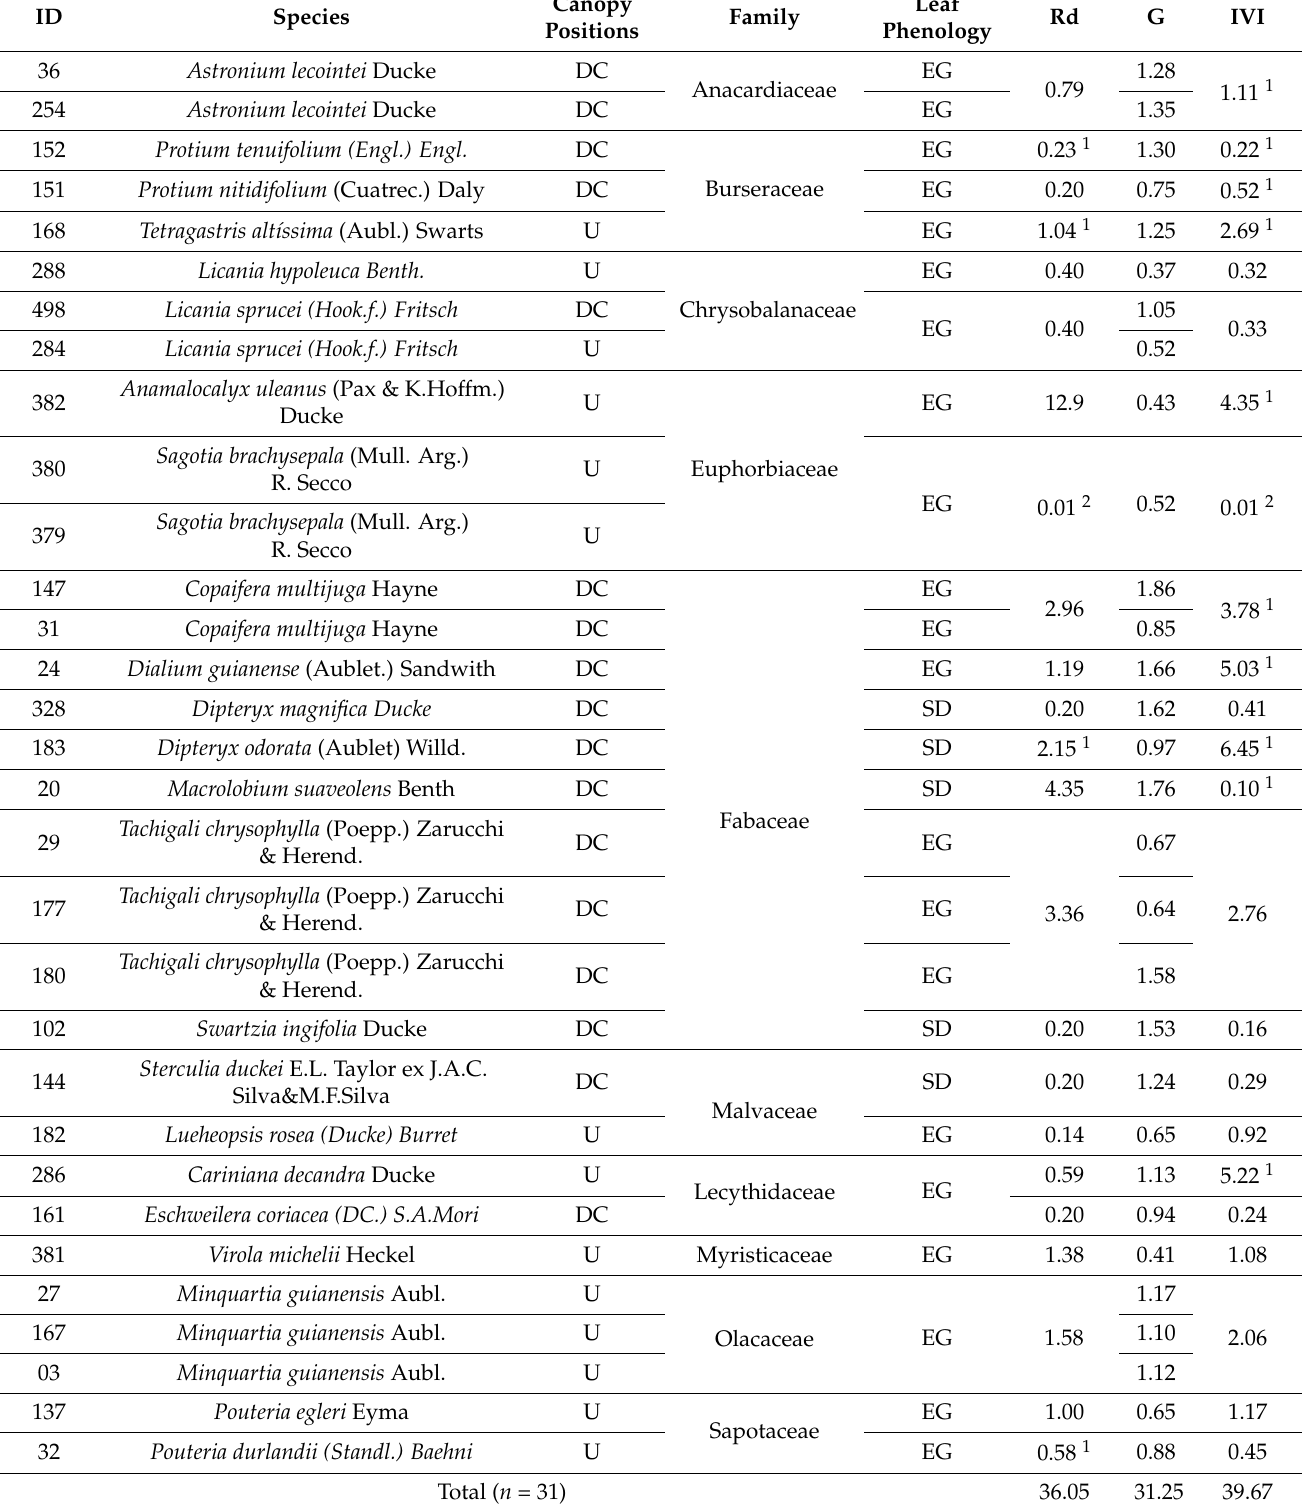
Table 2. Phytosociological parameters of the species